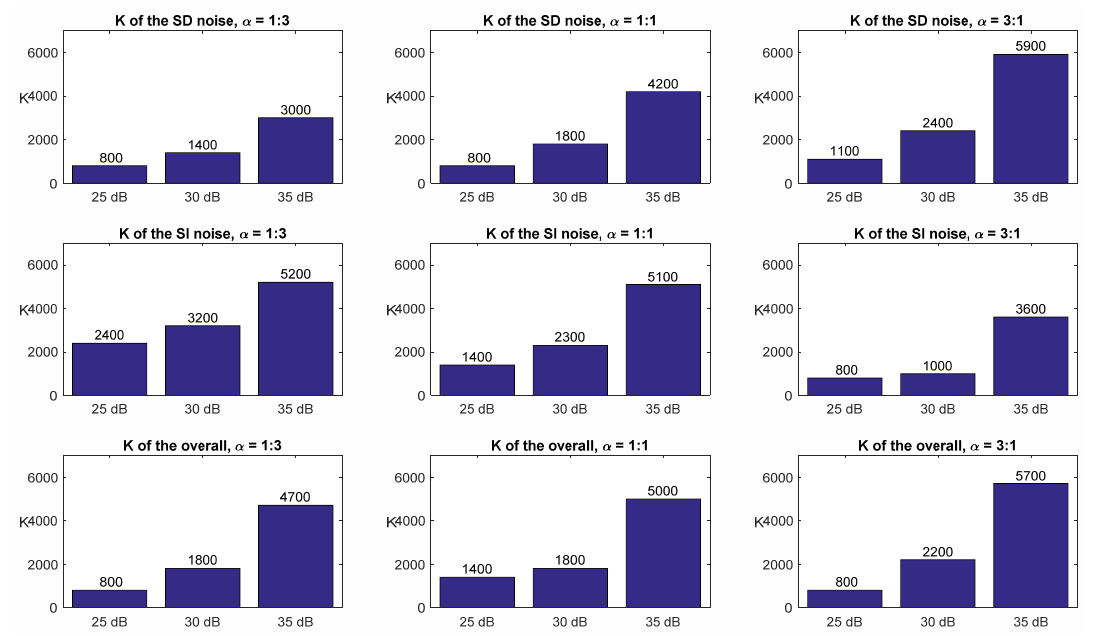
Figure 10. The number of superpixels K of the optimal relative error for the superpixel-based MLRLS.